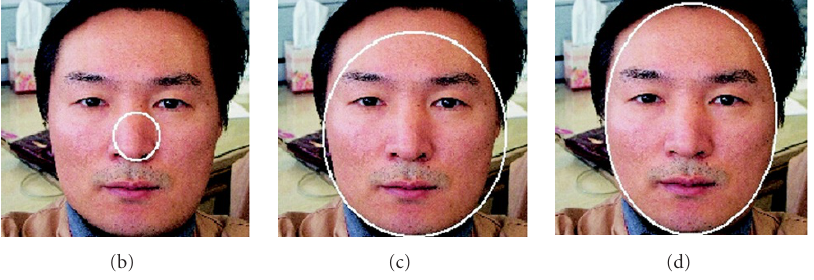
Here, R n , x , y denotes an ( n × 7)-sized rectangle centered at ( x , y ), while P n , r is an ( n × n/ 3)-sized ellipse centered at r . The control parameters are the scaling coe ffi cient, α , and the expected size of the eye features, n